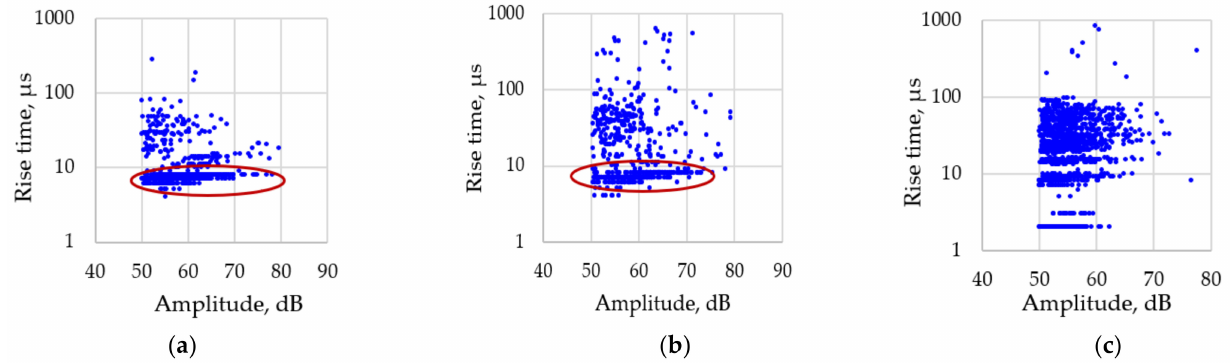
Figure 10. Rise time vs. amplitude scatterplots for AE hits registered under cyclic loading of a specimen with diffusion layers at σ max = 200 MPa ( a ) σ max = 300 MPa ( b ) and σ max = 400 MPa ( c